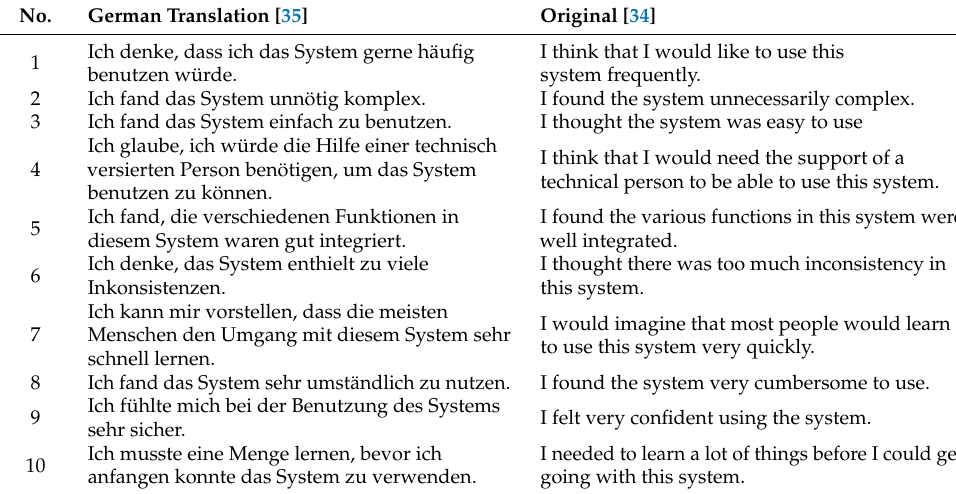
Table A1. System Usability Scale (SUS)